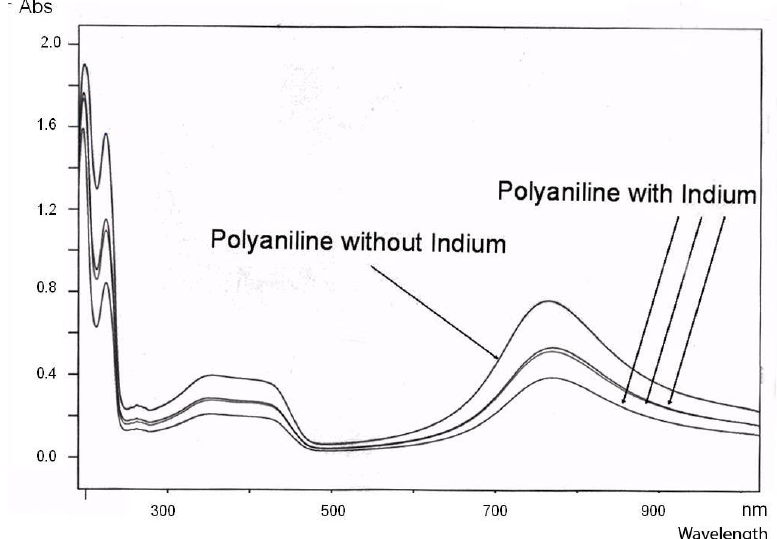
Figure 4. UV-Vis spectrum of polyaniline (pure) and polyanilne/In complex; the curve with the lowest absorption around 800 nm representing the complex after reaction